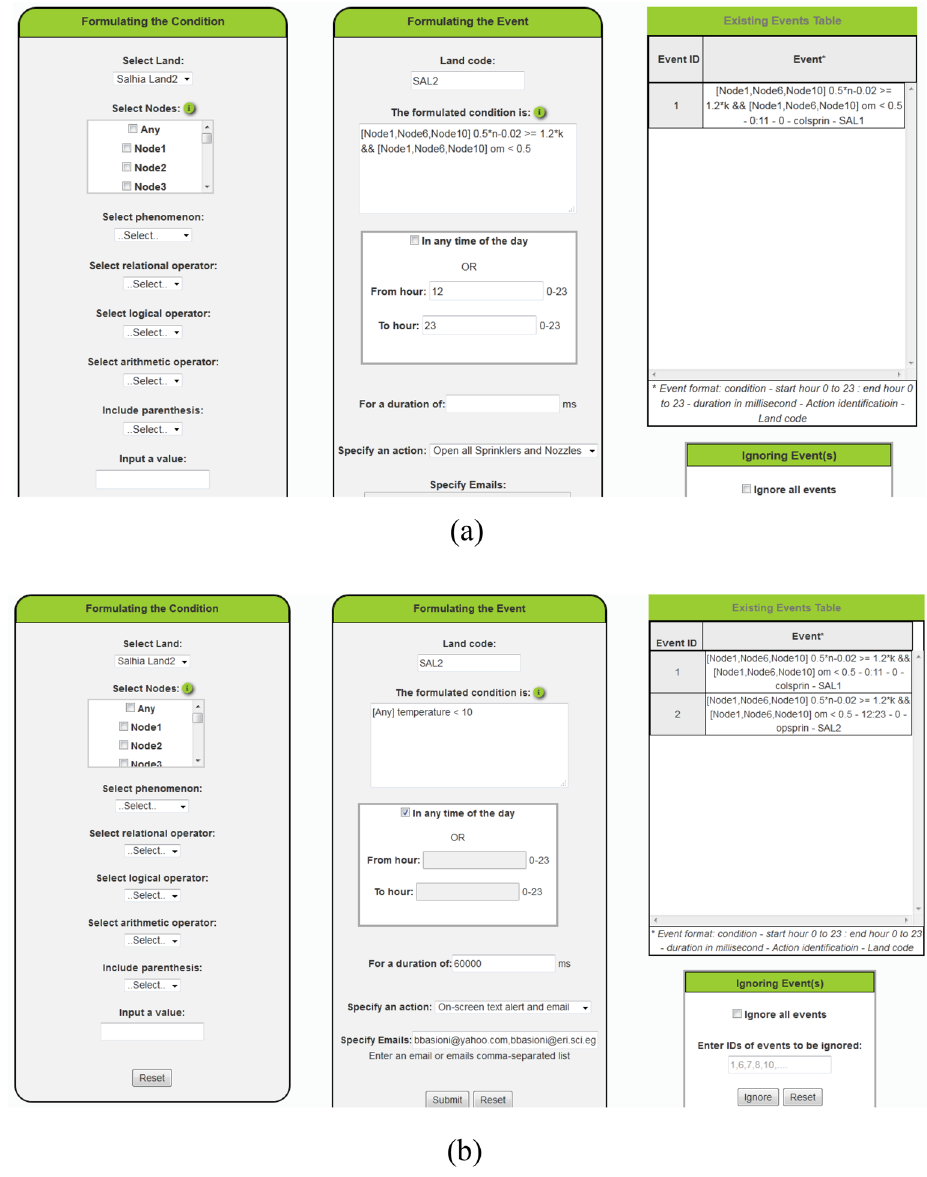
Figure 23. Formulation of the two events required by the validation test to be